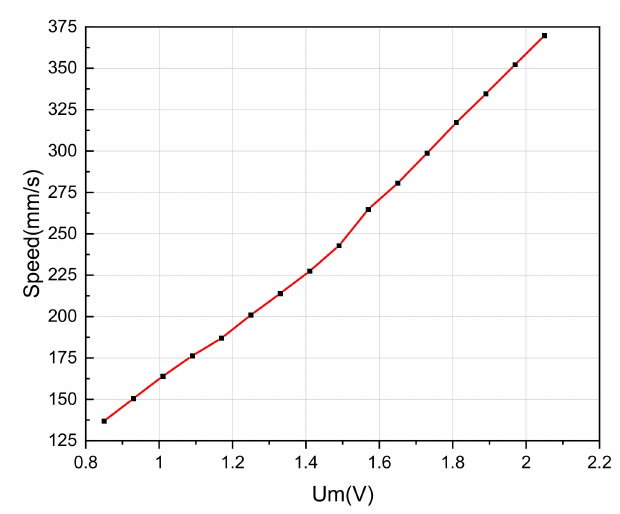
Figure 8. Frequency tracking process.